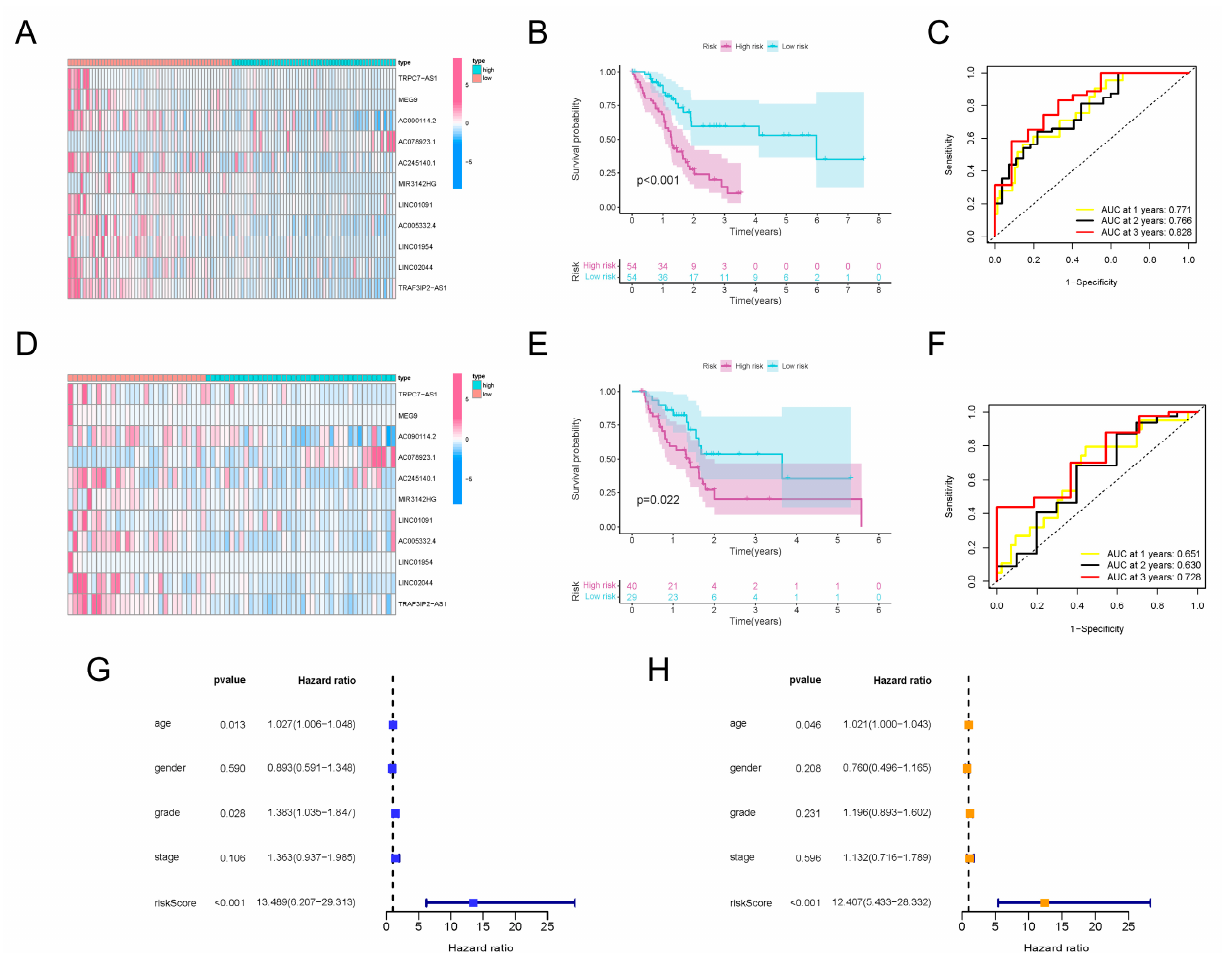
Figure 3. Construction and validation of m6A-lncRNA risk score signature. ( A ) Heatmap exhibiting expression values of 11 hub prognosis-relevant m6A-lncRNAs in cases from the training set. ( B ) K-M analysis clarifying different survival probabilities of PDAC patients in training set partitioned by risk score. ( C ) ROC curves validating the predictive efficacy of the m6A-lncRNA-based risk signature in the training set. ( D ) Heatmap exhibiting expression values of prognosis-related m6A-lncRNAs in cases from the testing set. ( E ) K-M analysis clarifying the survival probability of PDAC patients in the training set partitioned by risk score. ( F ) ROC curves validating the predictive efficacy of m6A-lncRNA-based risk signatures in the testing set. ( G ) The outcome of univariate independent prognostic analysis of all PDAC cases was visualized in forest plot form. The vertical dotted line represents the hazard ratio (HR) for all patients, and the length of the horizontal line shows the 95% confidential interval for each group. ( H ) The outcome of multivariate independent prognostic analysis of all PDAC cases visualized in forest plot form. The vertical dotted line represents the hazard ratio (HR) for each group, and the length of the horizontal line shows the 95% confidential interval for all PDAC patients.